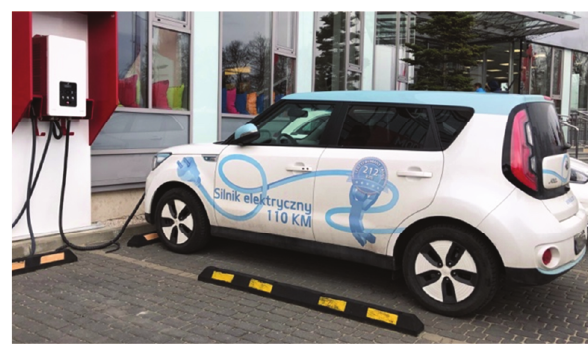
Fig. 2. An electric research vehicle